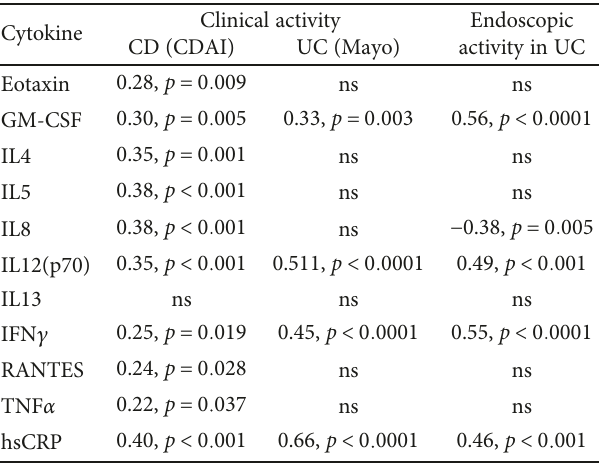
Table 1: Correlation between eosinophil-associated cytokines, chemokines, and growth factors and disease